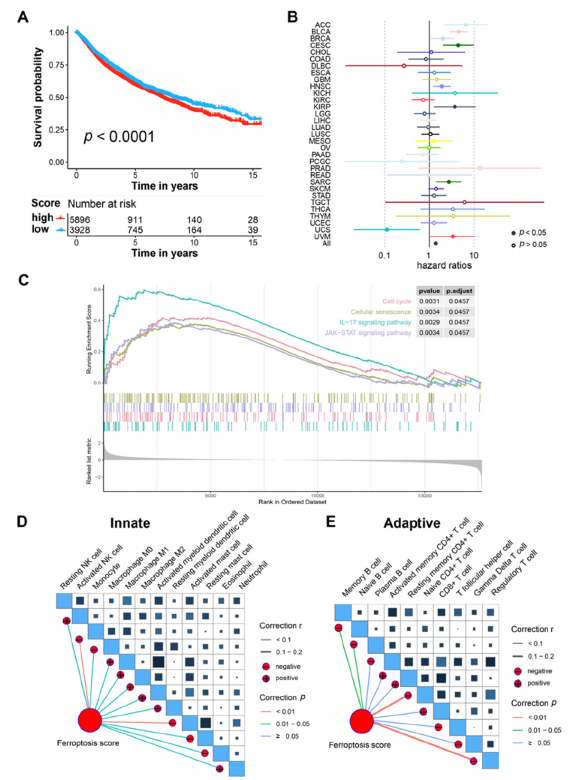
Figure 3. Enrichment and immunity analysis of the prognosis model in BCa. ( A ) Kaplan–Meier survival analysis of overall survival stratified by ferroptosis score for pan-cancer patients from the TCGA dataset. ( B ) Cox regression analysis of machine-learning-based ferroptosis score in different types of malignancies in the TCGA dataset. ( C ) Gene set enrichment analysis of patients with high ferroptosis scores. ( D , E ) Correlation analyses of ferroptosis scores and different adaptive immune cells ( D )/innate immune cells ( E ) in the TCGA cohort. BCa, bladder cancer; TCGA, The Cancer Ge- nome Atlas.